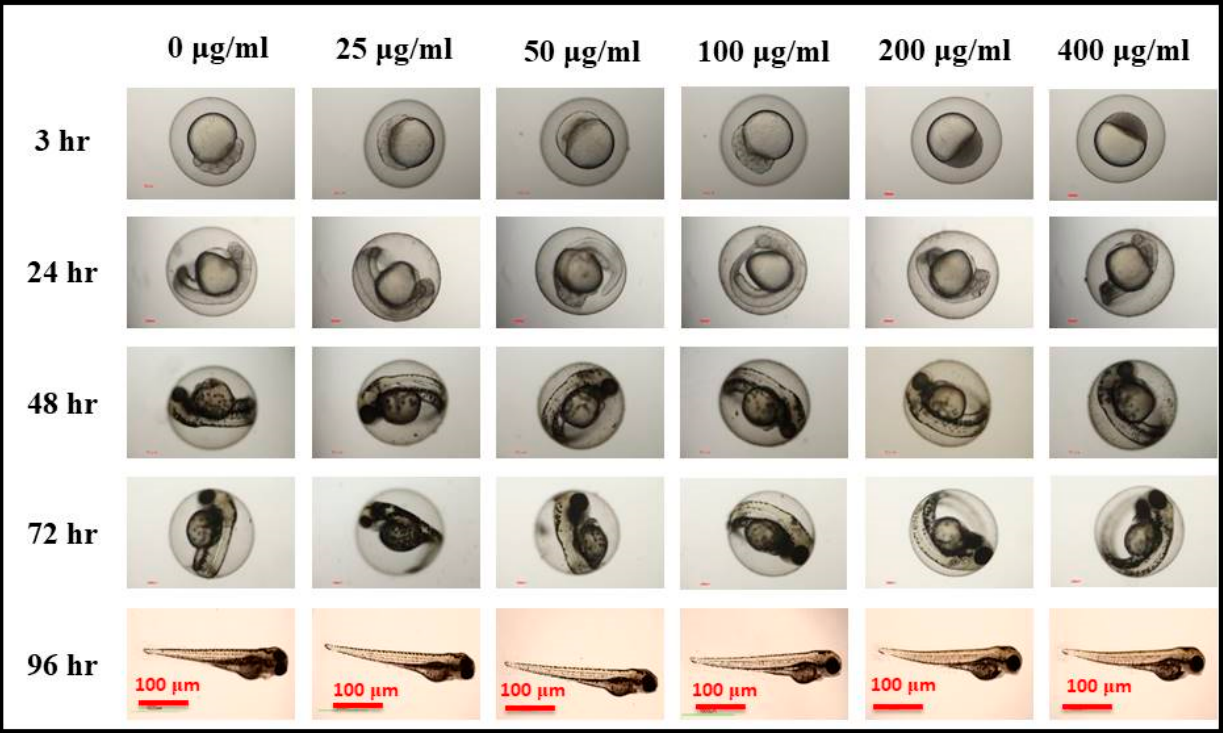
Figure 6. Optical microscopy images of representative developmental stages of zebrafish embryos in water containing different concentrations of GOQDs at different times. Scale bar 100 µm.